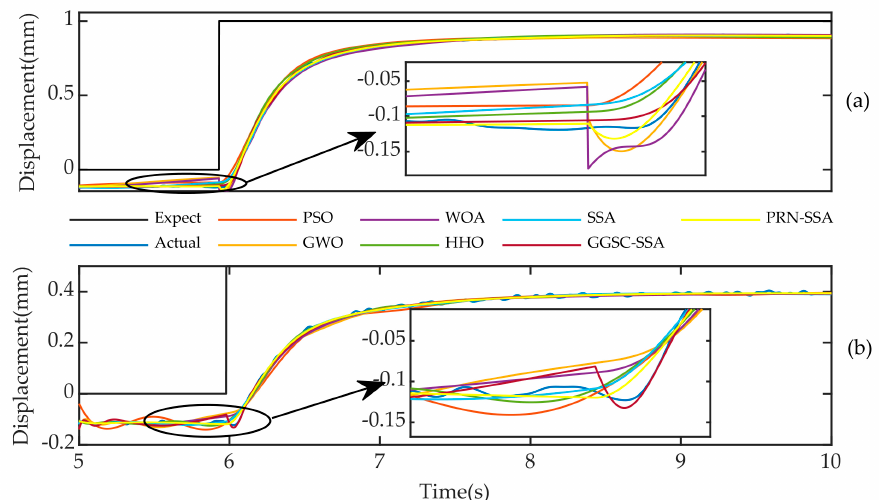
Figure 13. The actual output of the system and the simulation curve of the system output are identified by each algorithm (step signal): ( a ) Amplitude is 1; ( b ) Amplitude is 0.5.